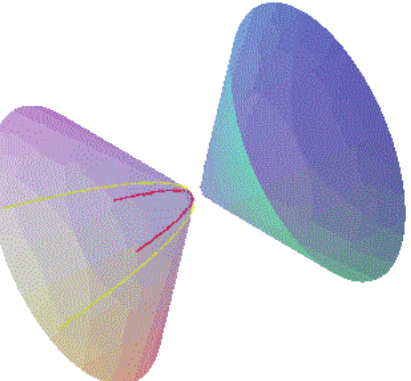
Figure 2: The 𝛼𝜉 -pseudohyperbolical Smarandache curve 𝛽 and the curve 𝛼 on 𝐻 2 0 (1) .